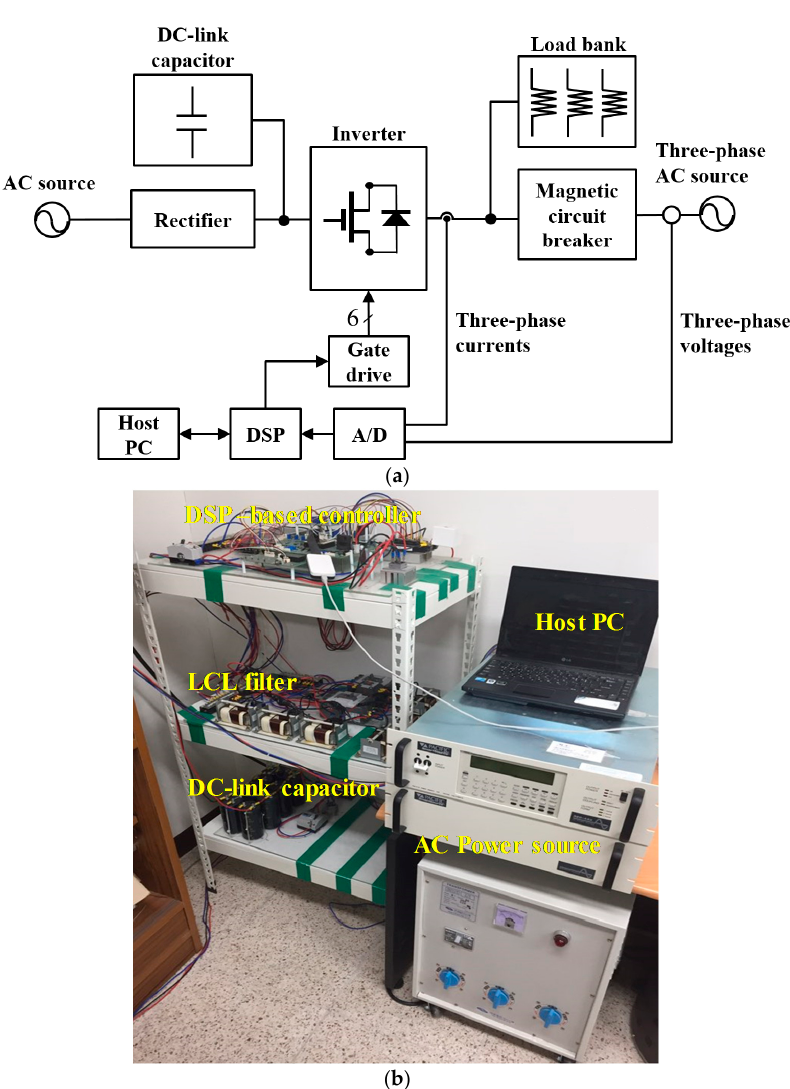
Figure 10. Configuration of the experimental system. ( a ) Block diagram of the overall system; ( b ) Photograph of the experimental setup. DSP: digital signal processor.